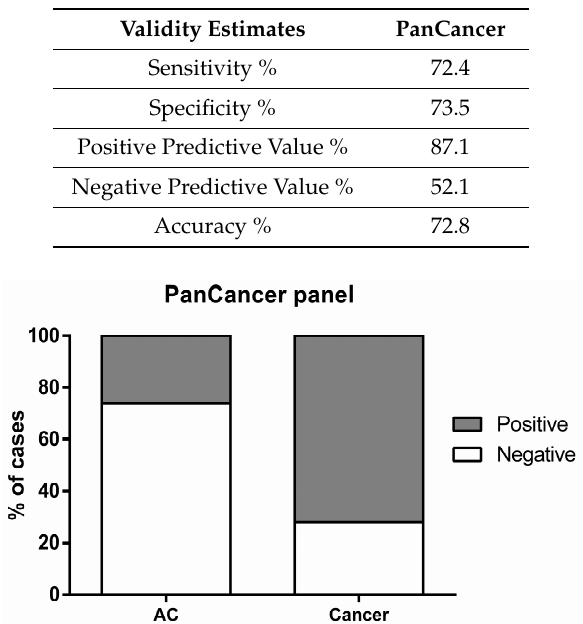
Figure 3 . Percentage of cases identified by “PanCancer” panel in cancer samples (Positive